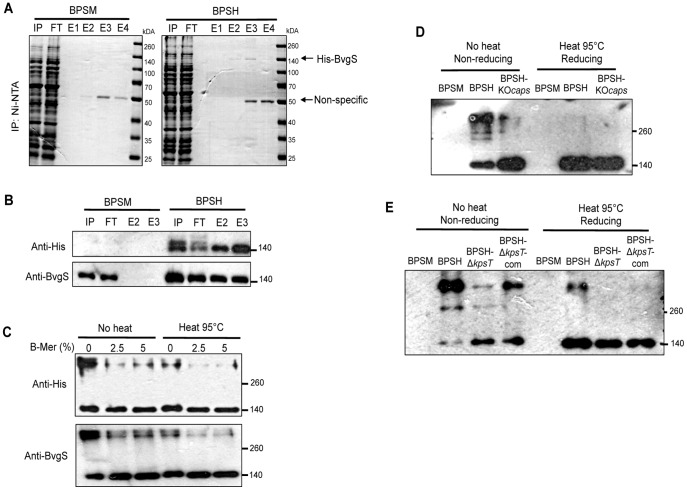
Expression and purification of His-BvgS from B. pertussis strains.(A) Coomassie blue analysis. 5 mg of solubilize cell lysate harvested from BPSM (untagged control) and BPSH was mixed with Ni-NTA agarose beads prior to loading onto a chromatography column. Lysate input, flow-through and batch eluted fractions were heated to 95°C for 15 min and analyzed under reducing 10% SDS-PAGE and stained with Coomassie blue. Lane IP; Input, FT; Flow through, E1; Eluted fraction 1, E2; Eluted fraction 2, E3; Eluted fraction 3, E4; Eluted fraction 4. Molecular weights are indicated on the right side. (B) Western blot analysis of purified fractions with anti-His and anti-BvgS antibodies. Lane IP; Input, FT; Flow through, E2; Eluted fraction 2, E3; Eluted fraction 3. Molecular weights are indicated on the right side. (C) Detection of BvgS associated oligomers and BvgS monomer. Purified His-BvgS from BPSH cells were mixed with equal volume of Laemmli SDS-PAGE buffer containing either no reducing agent (0% β-mercaptoethanol) or increasing concentrations (2.5% and 5% β-mercaptoethanol). The proteins samples were then subjected to either no heat or heat denaturation at 95°C for 15 min prior to SDS-PAGE analysis and Western blotted with anti-His or anti-BvgS antibody. Molecular weights are indicated on the right side. (D) Detection of BvgS associated oligomers and BvgS monomer in BPSH and BPSH-KO
caps
. Equal amount of purified His-BvgS from BPSH and BPSH-KOcaps cells were mixed with Laemmli SDS-PAGE buffer containing either no reducing agent or with 5% β-mercaptoethanol. The proteins samples were then subjected to either no heat or heat denaturation at 95°C for 15 min. Equal amount of protein were loaded for each well for SDS-PAGE analysis and Western blotted with anti-BvgS antibody. Molecular weights are indicated on the right side. (E) Detection of BvgS associated oligomers and BvgS monomer in BPSH, BPSH-Δ
kpsT
 and BPSH-Δ
kpsT
com. Equal amount of purified His-BvgS from BPSH, BPSH-ΔkpsT and BPSH-ΔkpsTcom cells were mixed with Laemmli SDS-PAGE buffer containing either no reducing agent or with 5% β-mercaptoethanol. The proteins samples were then subjected to either no heat or heat denaturation at 95°C for 15 min. Equal amounts of protein were loaded for each well for SDS-PAGE analysis and Western blotted with anti-BvgS antibody. Molecular weights are indicated on the right side.